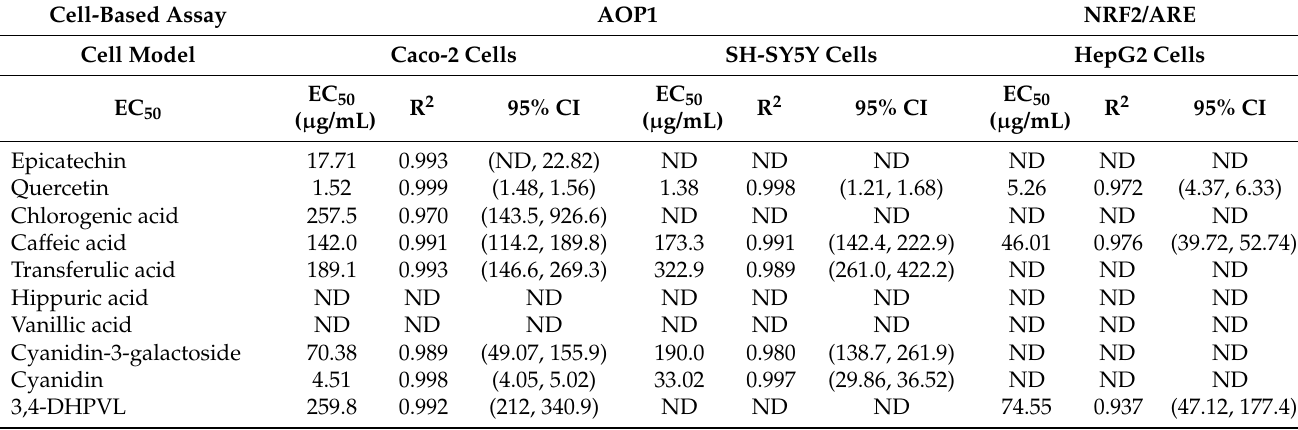
Table 3. EC 50 values for pure individual polyphenolic compounds and metabolites assessed by AOP1 and NRF2 bioassays in different cell lines. EC 50 values are expressed in micrograms of product per milliliter. Asymmetrical 95% CIs are indicated. R 2 is the coefficient of determination obtained by non-linear regression model fit. ND stands for no dose–response effect and in this situation EC 50 value could not be determined (no fit). There are no statistical differences among EC 50 values marked with the same symbol. All other EC 50 values are statistically different ( p < 0.05). AOP1 in HepG2 was only assessed for quercetin (EC 50 : 6.47 µ g/mL, 95% CI [6.13, 6.83] and epicatechin (EC 50 : 222.0 µ g/mL, 95% CI [201.5, 244.6]. The catalase-like assay in HepG2 was only performed for quercetin (EC 50 : 57.88 µ g/mL, 95% CI [ND, 80.06] and 3,4-DHPVL (EC 50 : 320.7 µ g/mL, 95% CI [223.9,